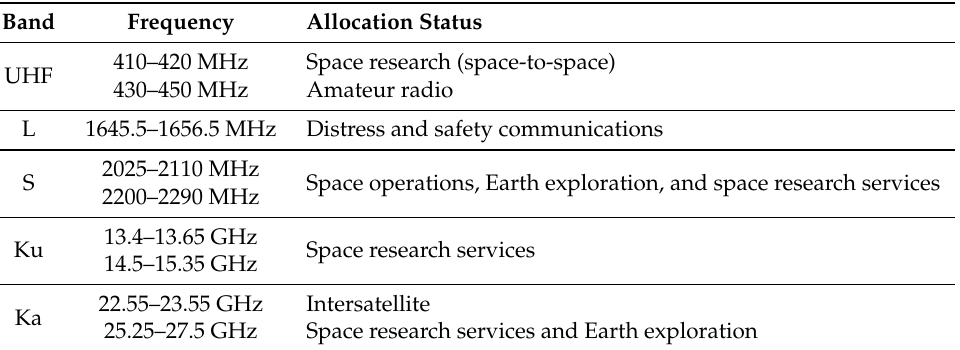
Table 5. Frequency bands for space-to-space